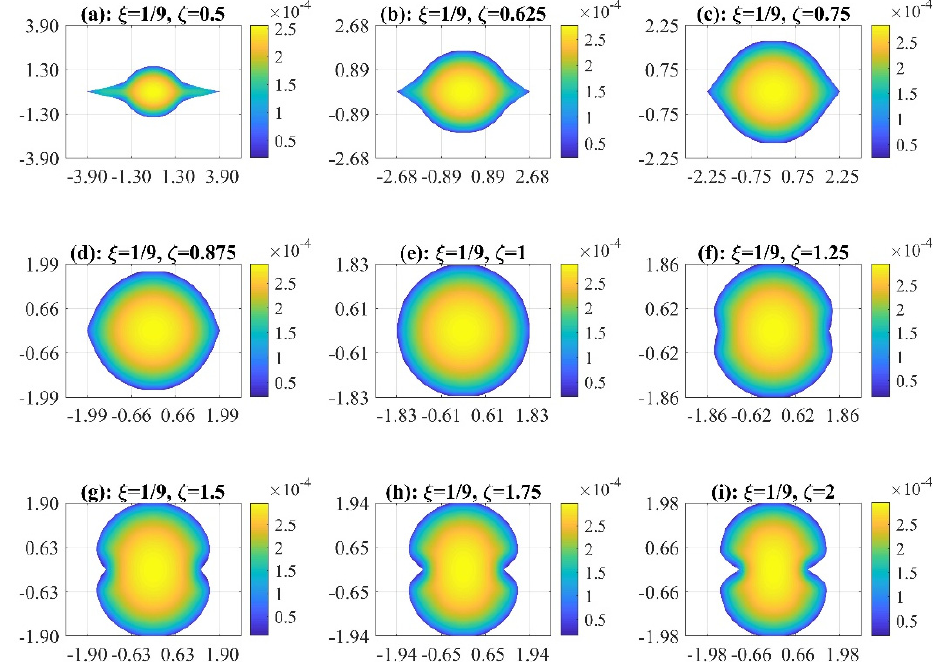
Figure 10. Distributions of fracture opening of Group 1 numerical experiments ( ξ = 1/9) with 9 different fracture toughness contrasts at the moment = 20 s .